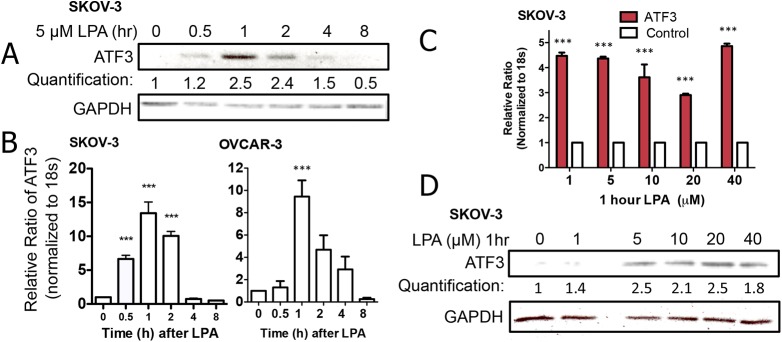
Lysophosphatidic acid induces the expression of ATF3.(A) SKOV-3 cells were treated with 5 μM lysophosphatidic acid (LPA) for the times indicated prior to assessment of ATF3 protein. (B) SKOV-3 and OVCAR-3 cells were treated with 5 μM LPA for the times indicated prior to qRT-PCR measurement and normalization of ATF3 transcripts. SKOV-3 cells were treated with increasing concentrations of LPA for 1 h before measuring ATF3 mRNA (C) or protein (D). ***p<0.001, comparing the indicated condition to time 0 or untreated control.